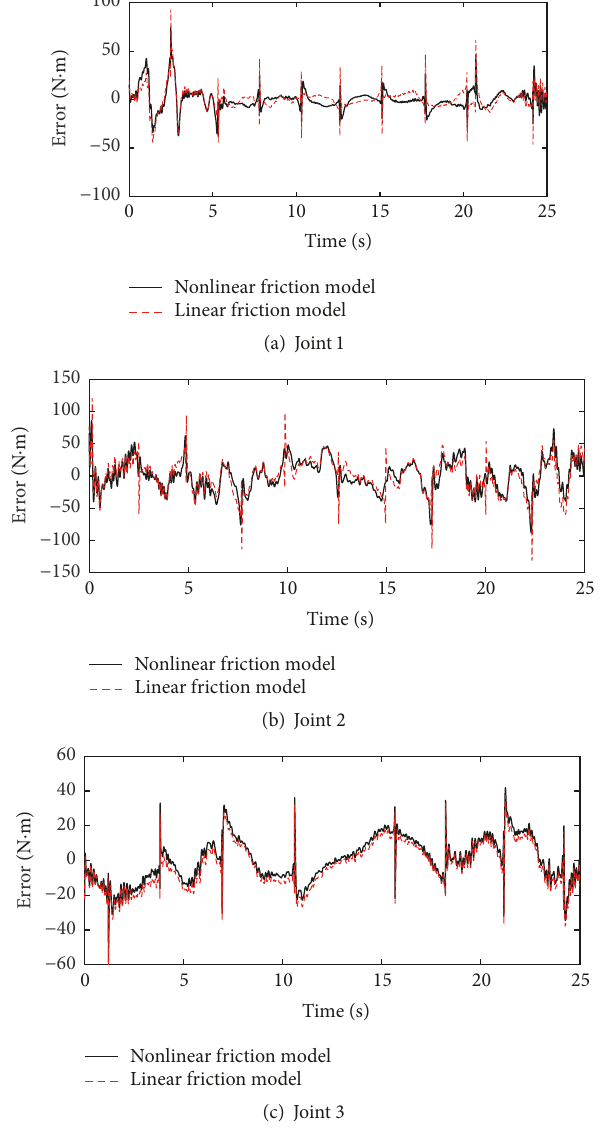
Figure 8: Comparison of linear and nonlinear models.